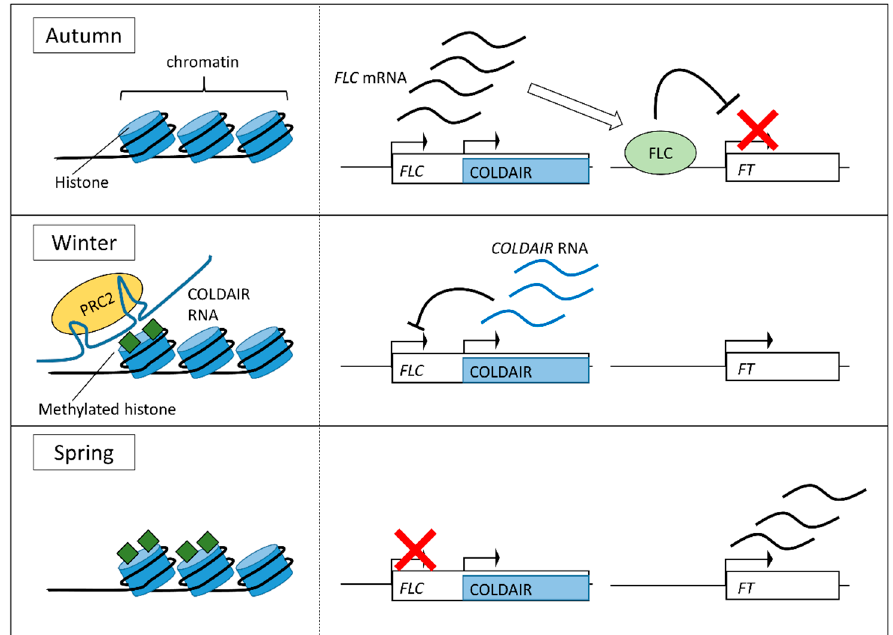
Figure 3. The mechanism of the vernalization system. The diagram shows chromatin state near the FLOWERING LOCUS C ( FLC ) gene (left), FLC and COLDAIR regions and their expression (center) and FT region (right). In autumn or under conditions which did not include a prolonged cold period, the FLC gene is expressed and the FLC protein suppresses the expression of FLOWERING LOCUS T ( FT ). Conversely, in winter, COLDAIR noncoding RNA is transcribed from the 1st intron of FLC . COLDAIR RNA binds to Polycomb Repressive Complex 2 (PRC2) and guides it to the FLC region in the chromosome. Polycomb Repressive Complex 2 starts methylation of histones in the FLC region and this methylation deactivates the expression of FLC . In the following spring, expression of COLDAIR stops, but FLC still remains suppressed. The FT is activated and then differentiation into flowering begins.